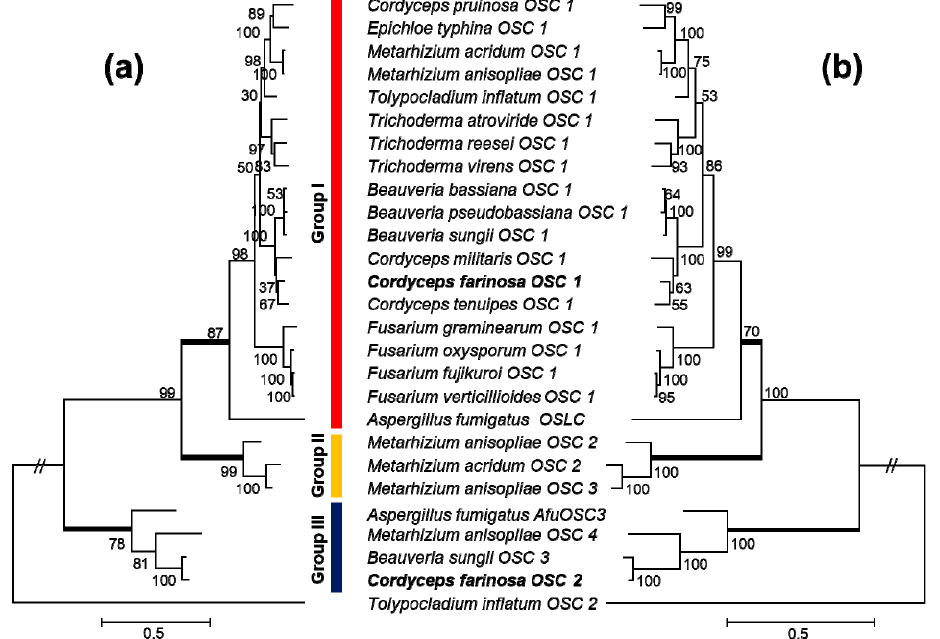
Figure 4. Phylogenetic tree of oxidosqualene cyclase (OSC) sequences extracted from selected Hypocreales species and inferred by neighbor joining (NJ, a ) and maximum likelihood (ML, b ) analyses. The number of changes among sequences is presented by branch length. The scale bar equals the number of nucleotide substitutions per site. Group I comprises genes homologous to lanosterol synthase (OSLC). Group III delimits orthologous of protostadienol synthase (OSPC). Three uncharacterized OSCs from Metarhizium spp . are nested in Group II.